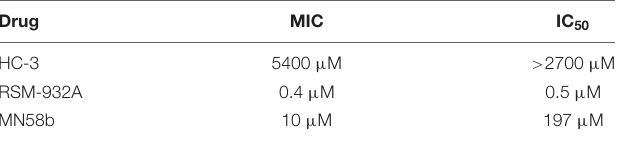
TABLE 1 | IC 50 and MIC of HC-3, RSM-932A and